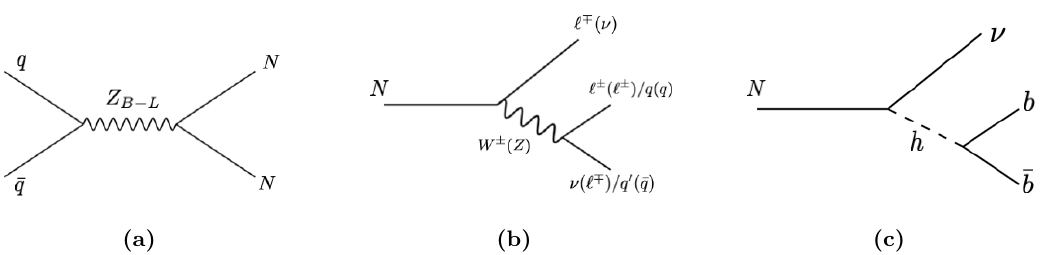
Figure 1. Feynman diagrams for generating RHN pairs via Z B − L at the LHC (a) and their further decays (b,